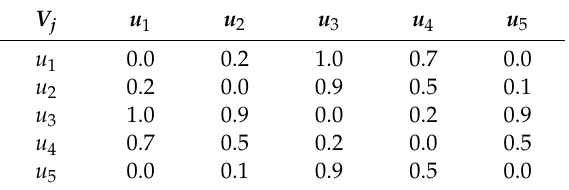
Table 7. Attribute value contradiction degree functions for j ∈ A ( c j ).